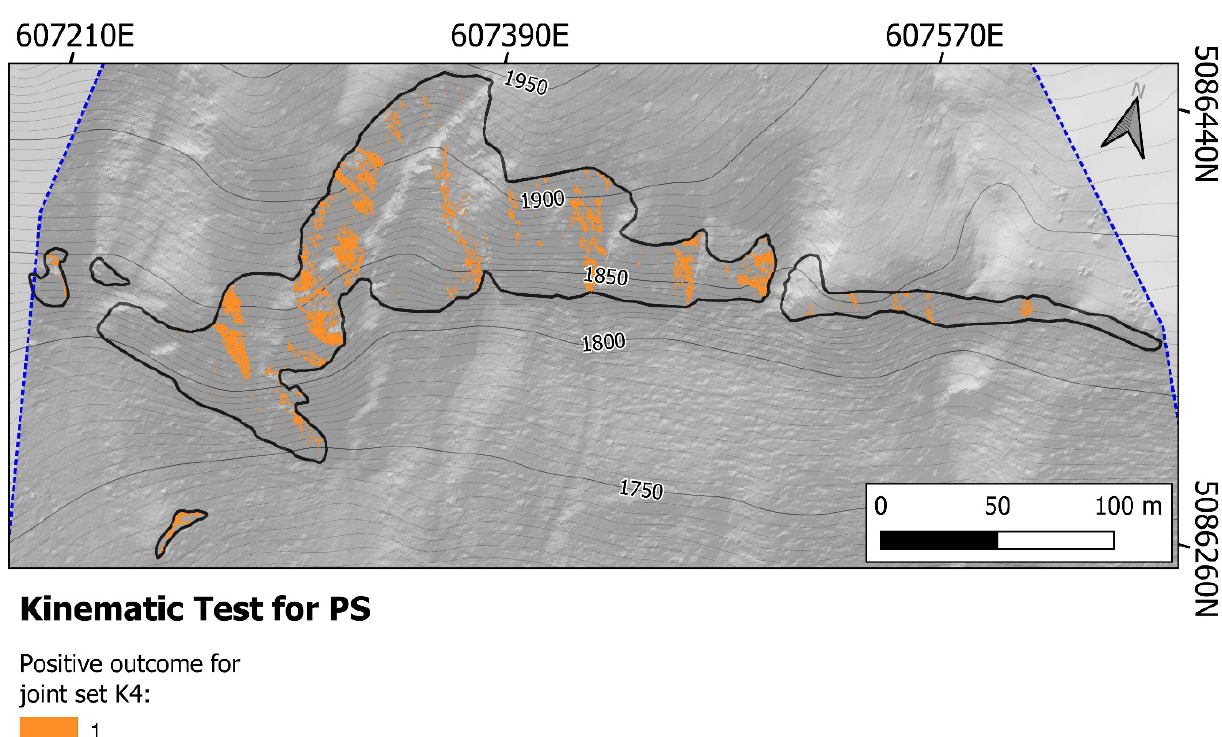
Figure A13. Image of the partial output file showing the kinematic test for TP performed considering only joint set K3.